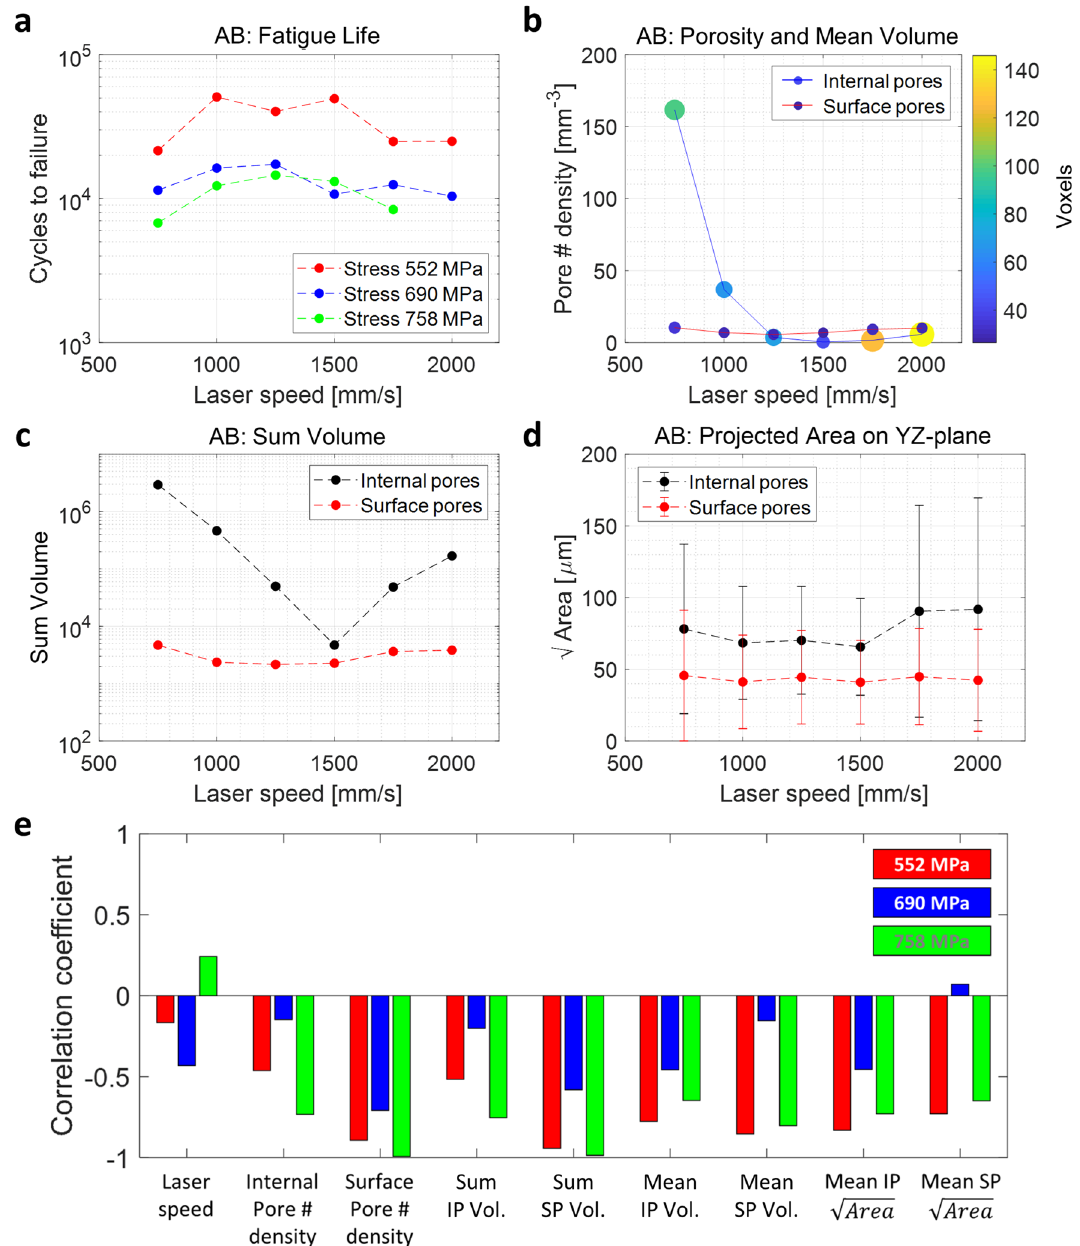
Figure 15. AB samples data correlation between HCF results and pore characteristics as a function of laser speed. (a) Number of cycle to failure, (b) pore number density (size and color of the markers represent the mean volume of the pore), (c) sum of pore volume, and (d) projected area of pores on the YZ-plane (error bars indicate the standard deviation), as a function of laser speed. (e) Correlation coefficients (AB samples) related to HCF cycles ( logN ). The parameter for projected area on the YZ-plane is denoted as